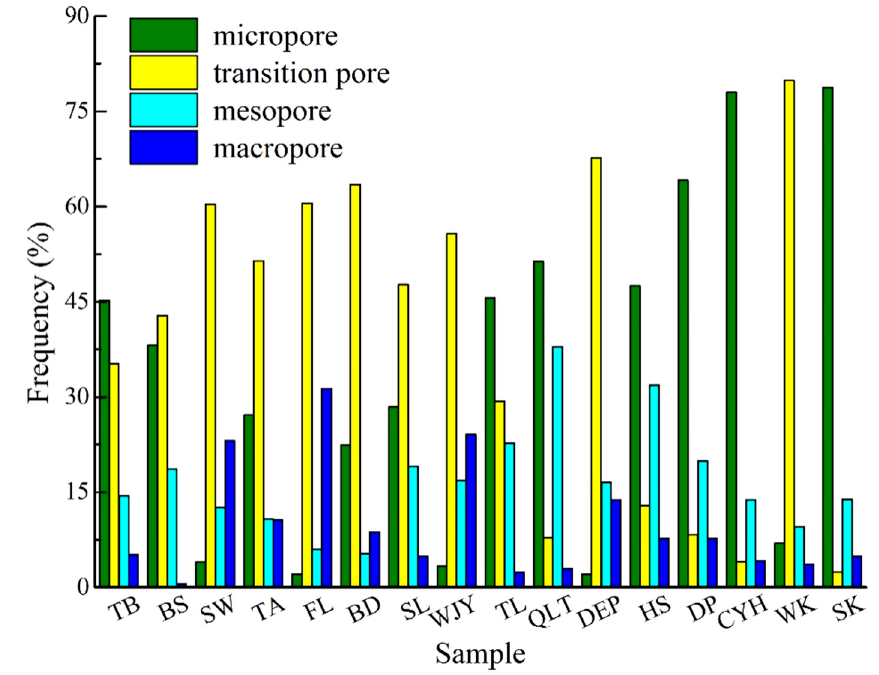
Figure 8. Nuclear Magnetic Resonance (NMR) pore size distribution characteristics.